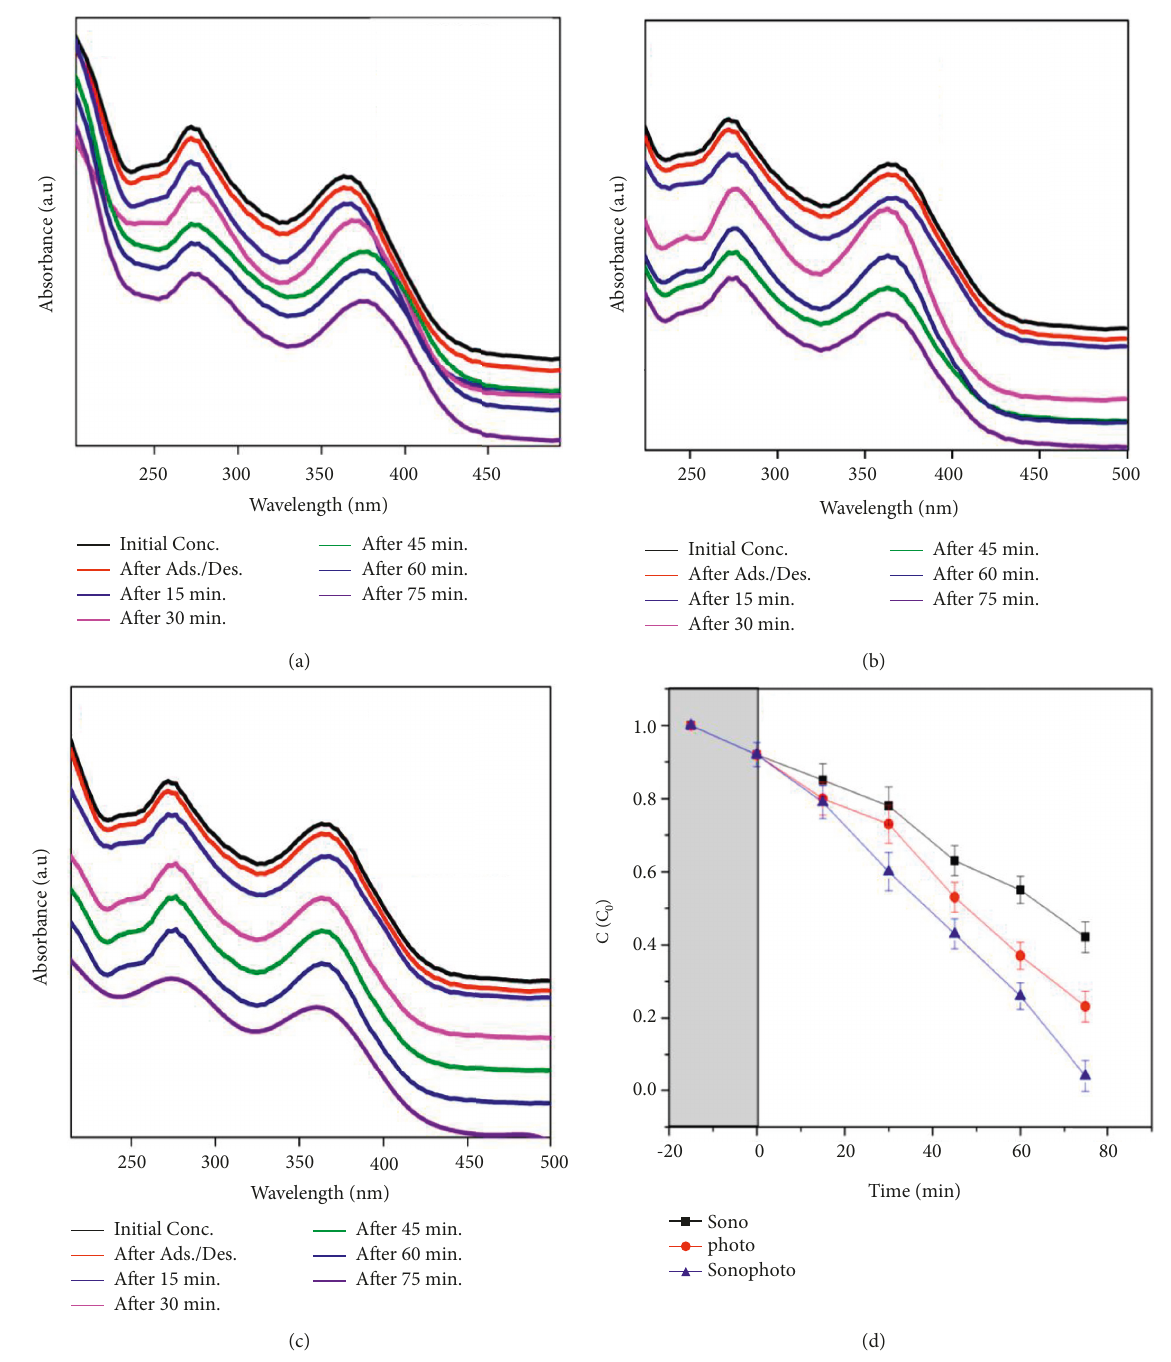
Figure 12: TC degradation by (a) Ni; (b) NiT; (c) NiTG (d) C/C